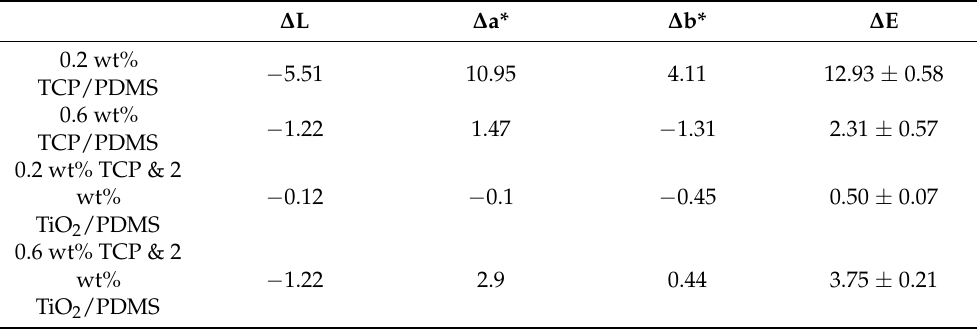
Table 7. Differences in color values ( ∆ L, ∆ a*, ∆ b* and ∆ E) between room temperature specimens and specimens stored at 40 ◦ C for 60 min.